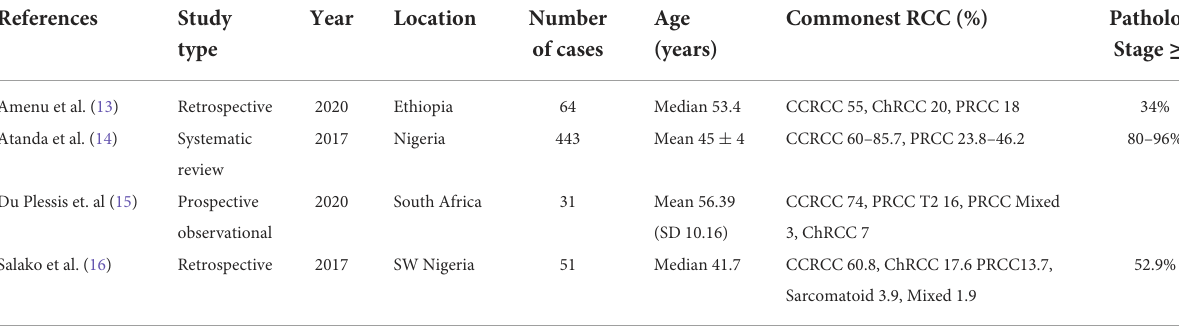
TABLE 5 Renal cell carcinoma clinicopathologic features in studies from